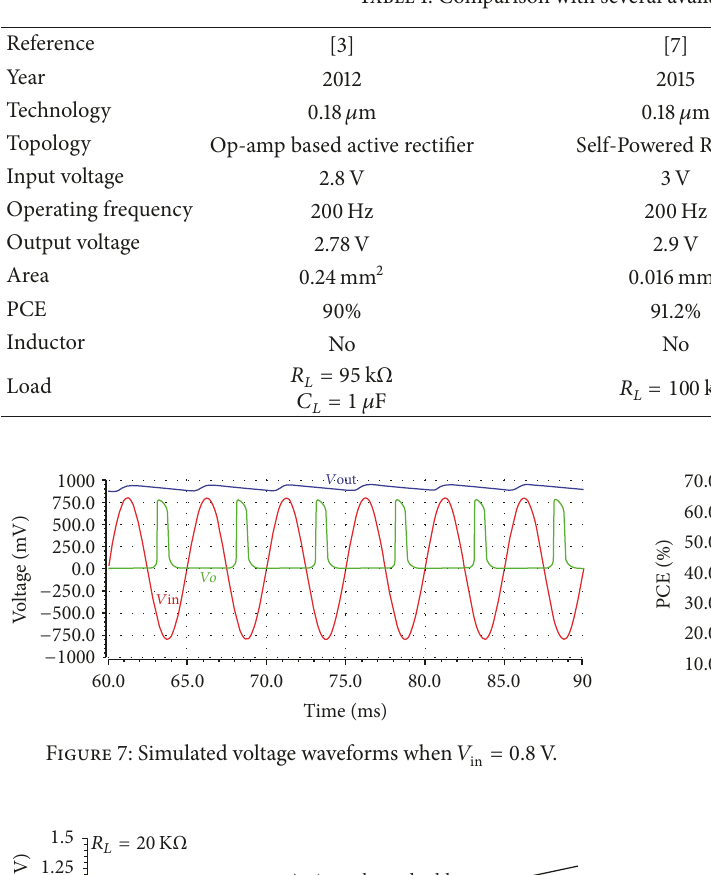
Table 1: Comparison with several available active rectifiers.